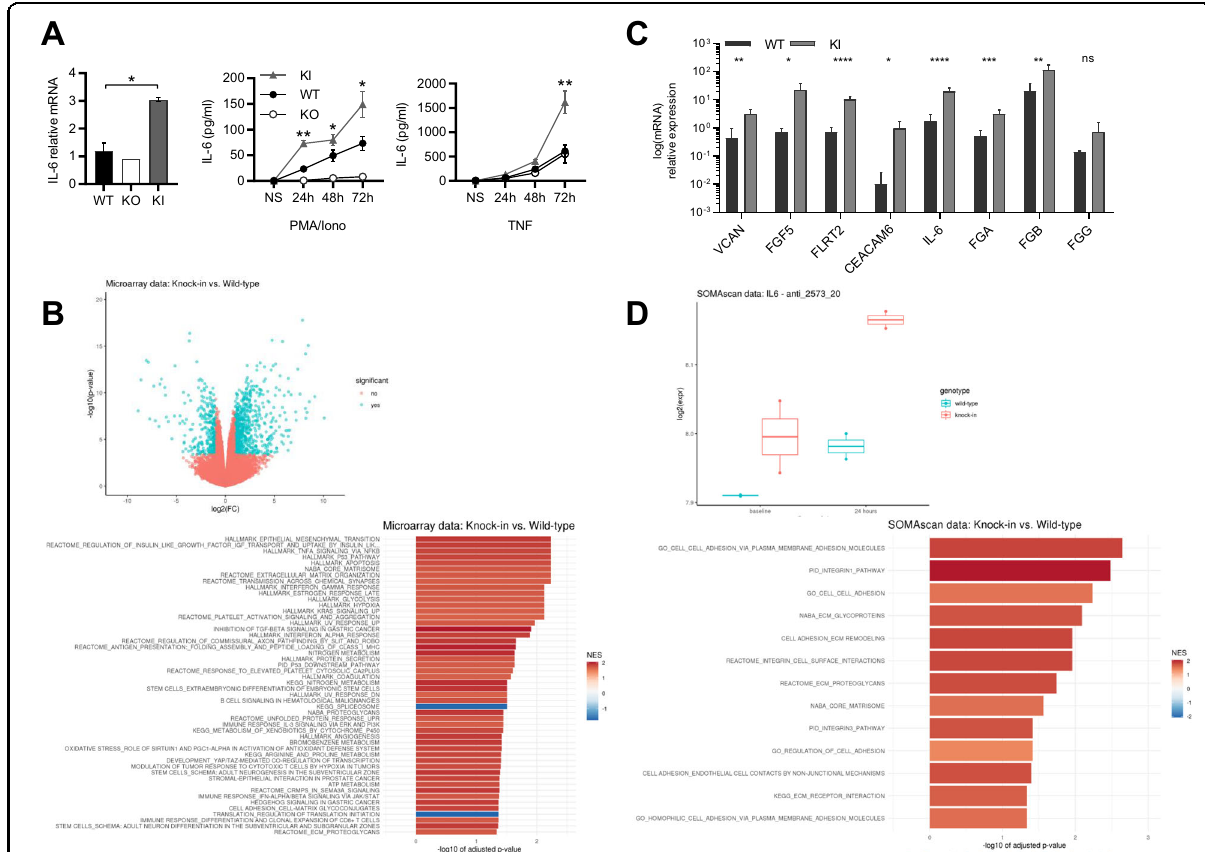
Fig. 4 CARD10 cleavage impacts IL-6 and extracellular matrix components. A IL-6 mRNA levels measured by RT-PCR (left), 72h-time course of released IL-6 protein levels measured upon P/I (50 µg/ml/1 μ M) (middle) or TNF (10 ng/ml) (right) stimulation. Data represent means ± SD of triplicates for two clones of each cell line ( N = 3). Statistical analyses were carried out using GraphPad Prism software. Differences among groups were assessed using one-tailed Student ’ s t tests. P < 0.05 was considered to be statistically signi fi cant. B Upper panel, Volcano plot of differential mRNA expression in A549-WT and KI cells; microarray probe sets with an absolute log2 fold change of ≥ 1 and a false discovery rate-adjusted p ≤ 0.01 are colored in blue. Lower panel, Gene set enrichment analysis of the data shown in the upper panel. Shown are the top 50 of 69 gene sets signi fi cant at a false discovery rate < 0.05. NES Normalized Enrichment Score. Highly signi fi cant pathways were (i) cancer (p53, KRAS) (ii) in fl ammation (NF- κ B, TNF), (iii) cancer-related processes (extracellular matrix (ECM), apoptosis, and angiogenesis), with a particular enrichment of gene sets linked to ECM regulation (matrisome, ECM organization, proteoglycans, cell adhesion-matrix glycogonjugates, and ECM proteoglycans). C Relative quantitative PCR measurement of eight selected mRNAs contributing to ECM regulation signatures at basal level in A549-WT or KI: Versican (VCAN), Fibroblast growth factor 5 (FGF5), Fibronectin Leucine Rich Transmembrane Protein 2 (FLRT2), CEA Cell Adhesion Molecule 6 (CEACAM6), Interleukin-6 (IL-6), and fi brinogen genes FGA, FGB, and FGG). Means ± SD of triplicates for two clones of each cell line are shown ( N = 2). Statistical analyses were carried out as described in ( A ). Microarray values for the eight leading edge mRNAs (Fig. 4C) are shown in Supplementary Fig. 8. D Upper panel, Box plot of IL-6 protein levels as measured by SomaScan (SOMAmer anti_2573_20) in A549-WT and KI cells, at baseline and after a 24 h stimulation with P/I. Lower panel, Gene set enrichment analysis of longitudinal SomaScan data comparing the effects over time in A549-WT and KI cells. A selection of 124 gene sets related to ECM regulation was used. Shown are the 13 gene sets signi fi cant at a false discovery rate < 0.05; NES Normalized Enrichment